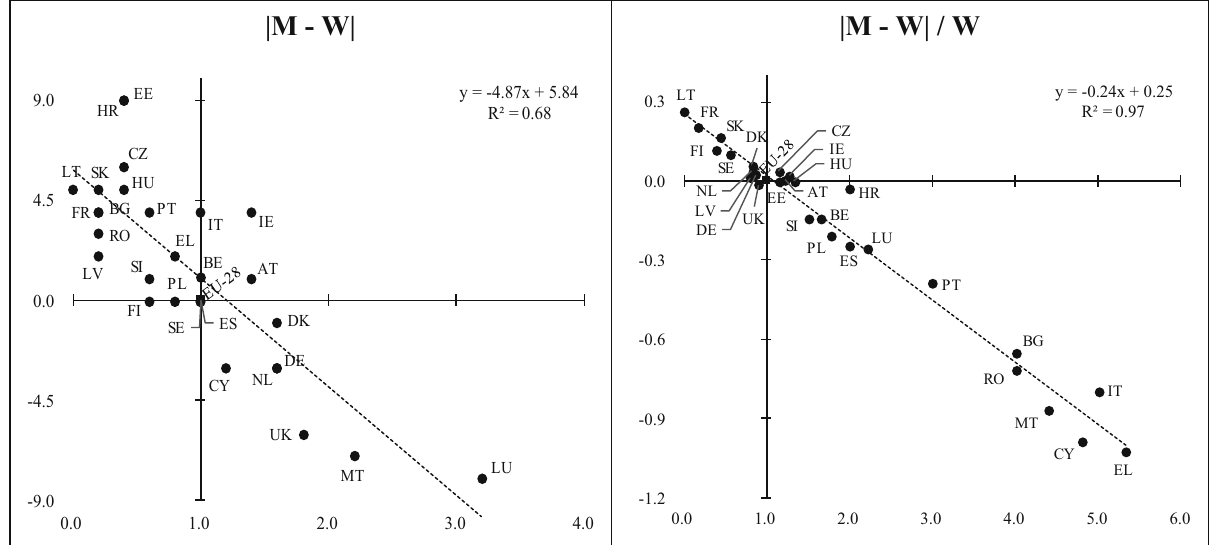
Figure 9: β - convergence of the digital gender gap ( ICT - PURCHASE ) in the EU - 28, 2007 – 2019. Note: The digital gender gap is de fi ned as the disparity between men and women in Internet purchases ( ICT - PURCHASE indicator ) , expressed in absolute terms, as a M − W di ff erence, and in relative terms, as a ratio ( M − W ) / W , taking the numerical value and omitting the sign. In each case, the abscissa represents the relative situation of the digital gender gap ( without considering the sign ) with respect to the EU - 28 ( which represents the unit ) in the 2007 gap. The variation di ff erential of the gender digital gap with the EU is represented on the ordinate. Source: Own elaboration from the Digital Economy & Society Database ( Eurostat ) .